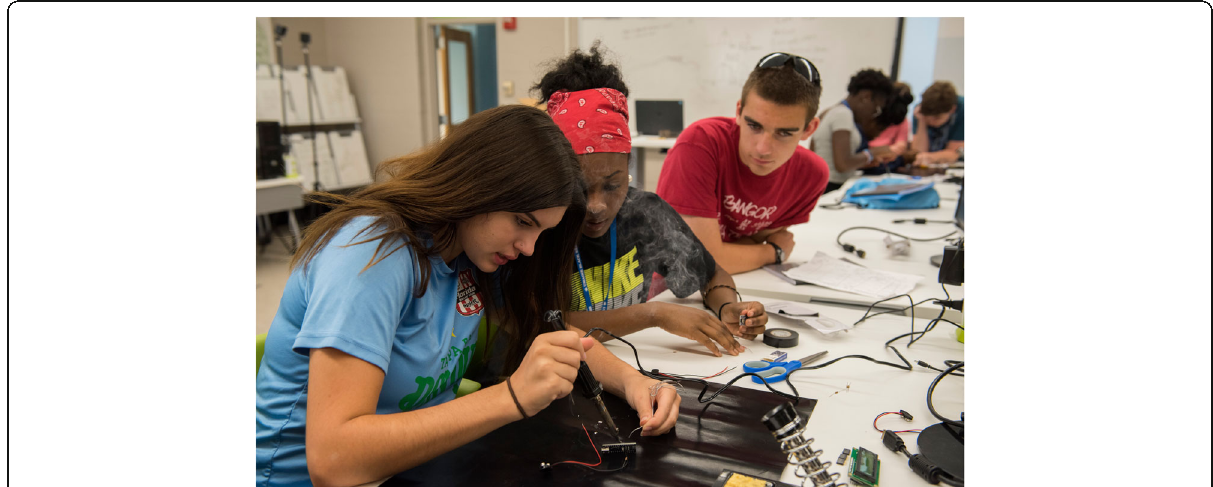
Fig. 2 Students soldering circuits for their temperature